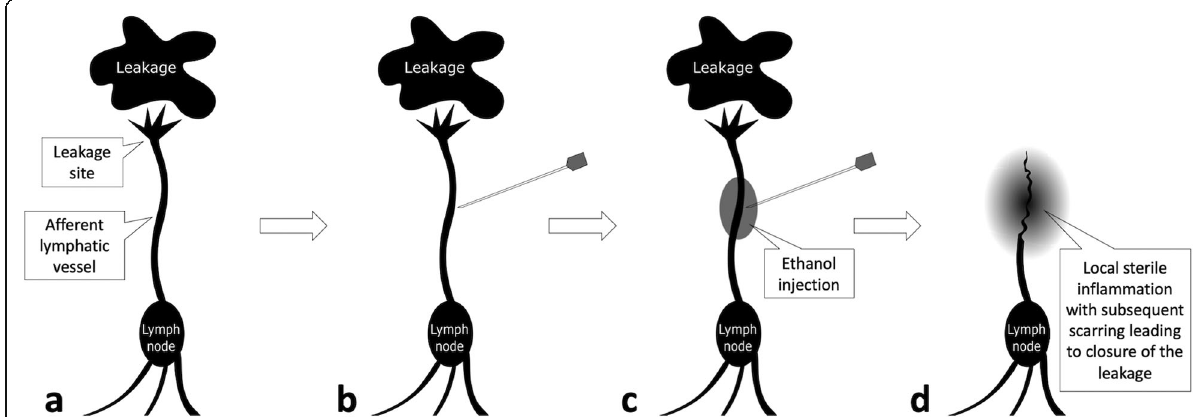
Fig. 1 The ALVS treatment. a The definite LL site and the afferent lymphatic vessel as the target for the following ALVS treatment should be identified using TL and CT. b In the ALVS procedure, the needle was used to puncture as close as possible to the afferent lymphatic vessel. c After the confirmation of the ideal distribution of the prior injected contrast, 95% ethanol as sclerosant was injected. d Afterwards, the local sterile inflammation led to the local scarring and subsequent obliteration of the afferent lymphatic vessel. Then, the leakage ceased. ALVS Afferent lymphatic vessel sclerotherapy, CT Computed tomography, LL Lymphatic leakage, TL Transpedal